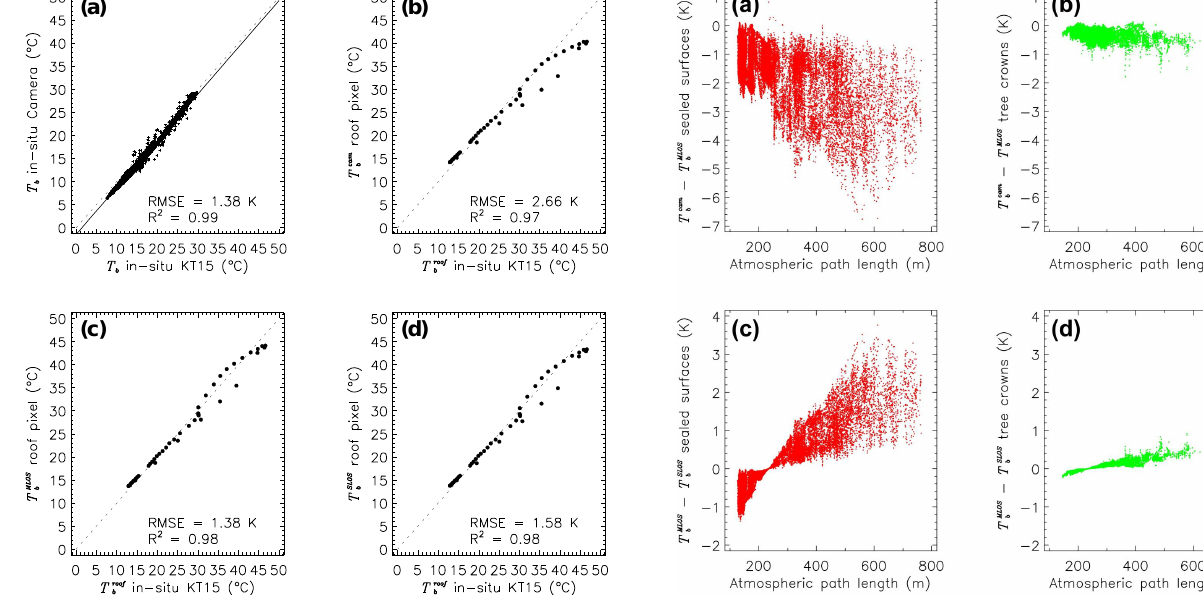
Fig. 9. (a) Instrument comparison over 10 days in April 2010 and relation between T roof in-situ and the corresponding remote sensing b